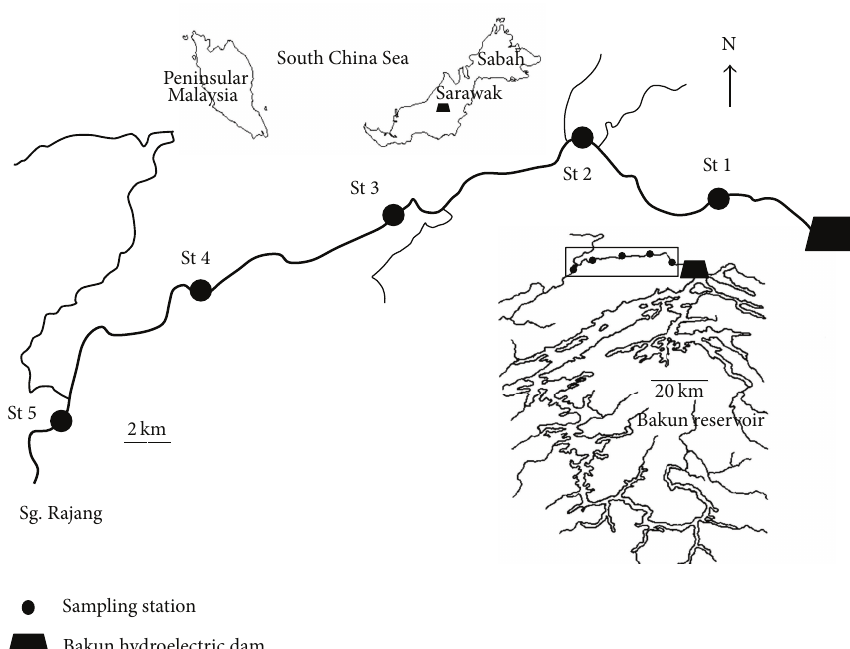
Figure 1: Location of the sampling stations along the downstream river, Balui River, of the Bakun hydroelectric dam in the present study in the state of Sarawak,